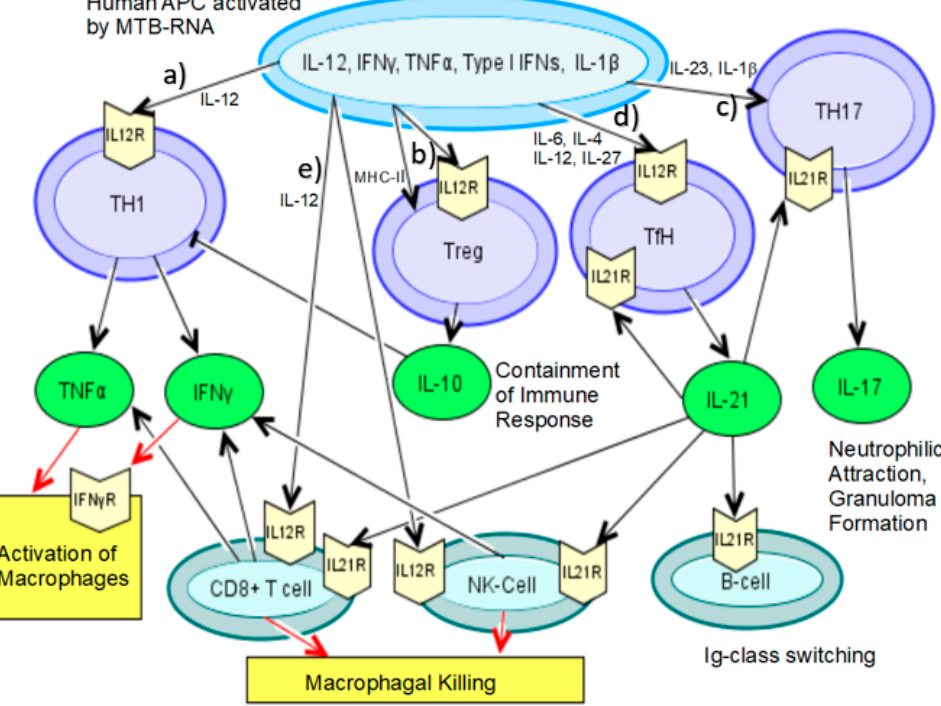
Figure 2. Induction of T-cell compartments after activation of human APCs with mycobacterial RNA. ( a ) At the beginning of the cascade triggered by human APC activation through mycobacterial RNA is IL-12, which will induce naive T-cells to differentiate into Th1 cells through the active from of IL-12p70 leading to production of IFN γ and TNF α , activating macrophages [23]. ( b ) Th17 T-cells are activated by IL-1 β , IL-23, which contains the IL-12p40 unit, and IL-21, leading to granuloma